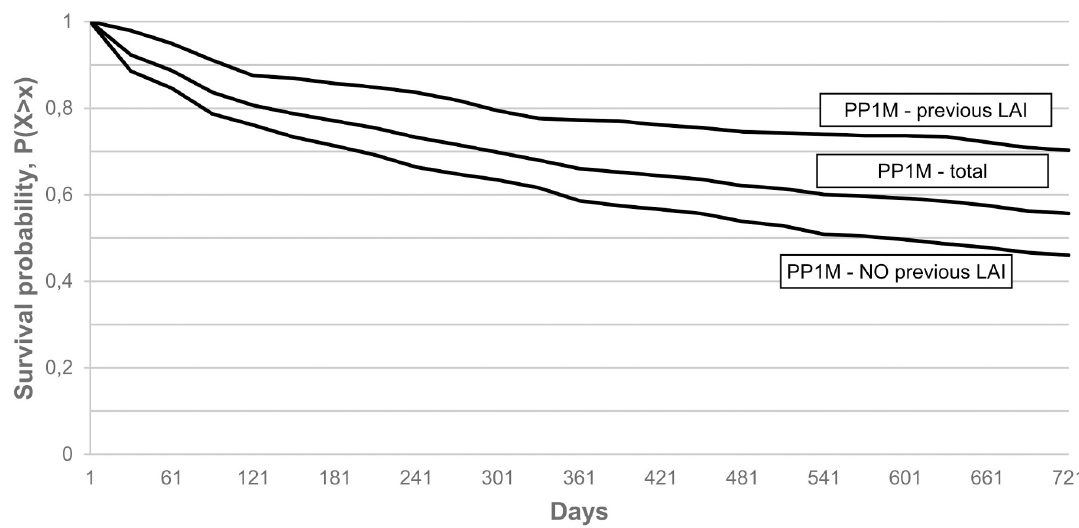
Fig 2. Kaplan-Meier survival of PP1M treated subgroups with 60 days grace